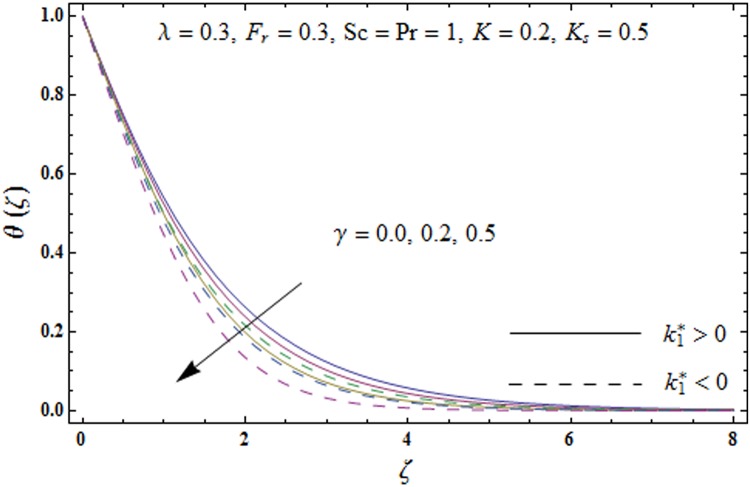
Plots of temperature field θ(ζ) for thermal relaxation parameter γ.